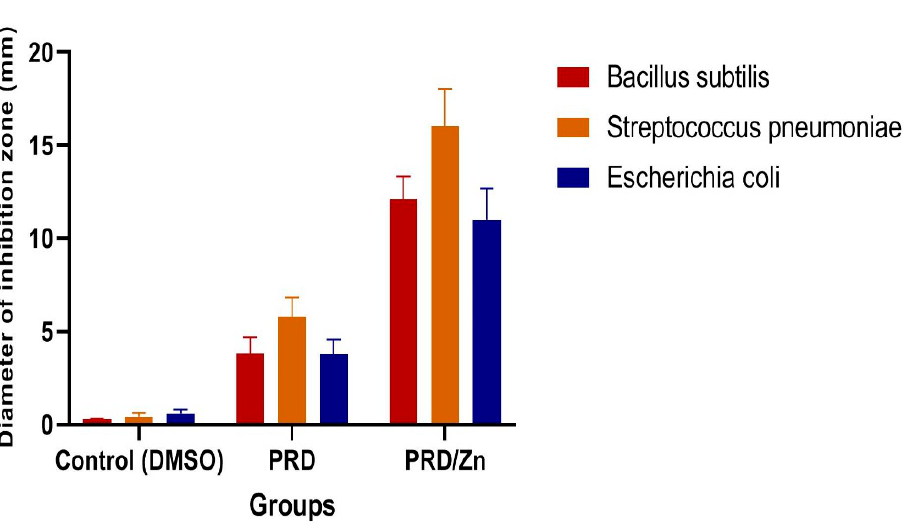
Figure 10. Antibacterial activity of the PRD and PRD/Zn metal complexes . Table 4. Diameter of the inhibition zone (mm/mg sample) of the PRD and PRD/Zn metal com- plexes.